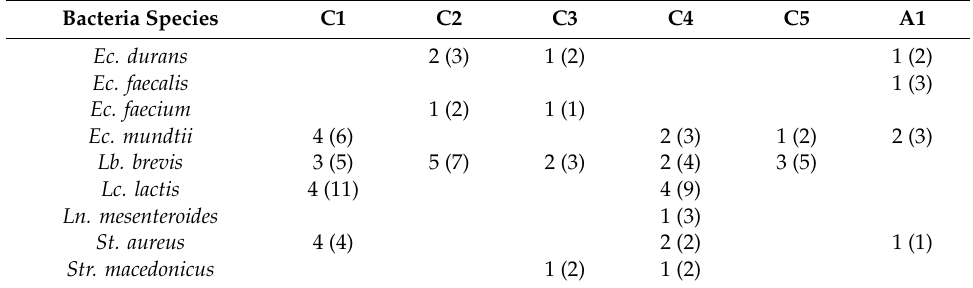
Table 5. Distribution of the bacterial isolates in the studied donkey milk